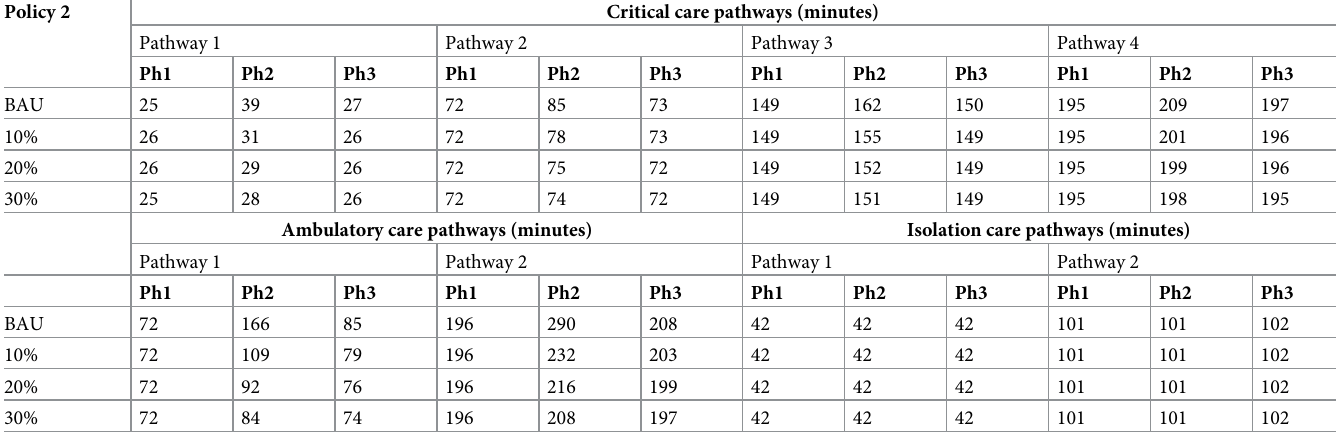
Table 2. ALOS ED patients face depending on care venue, patient pathway, arrival time for policy where the numbers of doctors are increased from 10% - 30% across all venues of care. Policy